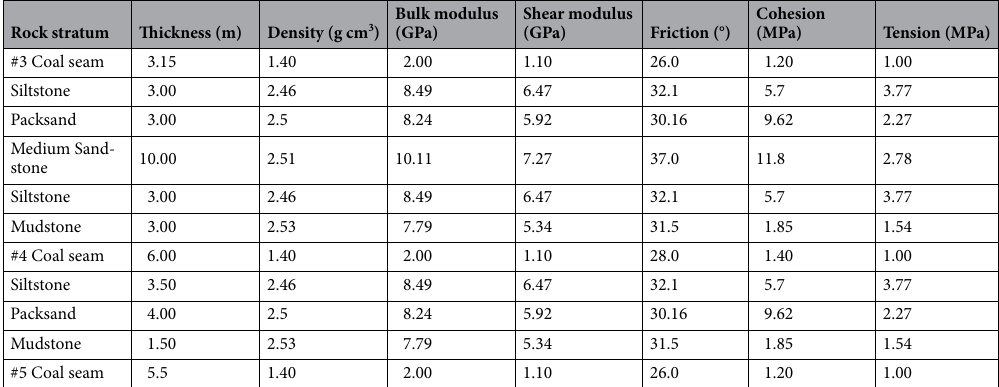
Table 3. Numerical simulation of physical and mechanical parameters of coal and rock.